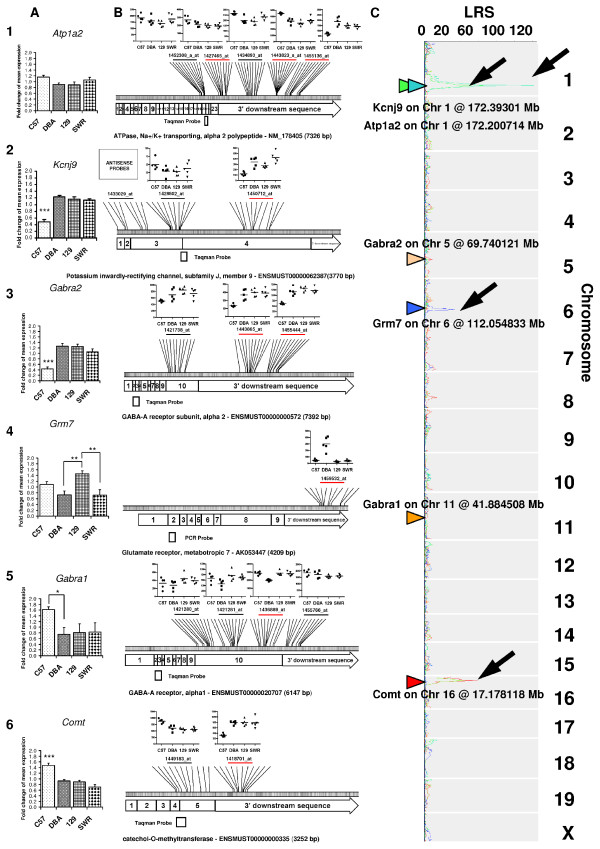
Analyses of gene expression of the six candidate genes by qPCR method (A), multiple probe-sets from the microarray (B) and genome-wide interval mapping (C). A. Results of qPCR are presented as fold change of average expression level across all the four mouse strains. Transcript region covered by Taqman probe is marked in the scheme of transcript structure. Error bars represents ± standard error of the mean from 6–9 individual animals. Statistical significance was determined by using ANOVA analysis followed by Tukey post hoc test (*p < 0.05, **p < 0.01, ***p < 0.001). B. Relative inter-strain differences in expression are presented as results from the multiple probe-sets measured by the MBEI method. Each probe was aligned with mRNA sequence and exon structure downloaded from Ensembl or GenBank databases. Image displays signal intensity from an individual array with emphasized mean value. Array probe-sets marked in red were found to be significantly different between the four strains of mice. C. Genome-wide interval multiple mapping for six probe-sets (Atp1a2 – 1455136_at, Kcnj9 – 1450712_at, Gabra2 – 1443865_at, Grm7 – 1459532_at, Gabra1 – 1436889_at, Comt – 1418701_at) in WebQTL (HBP/Rosen Striatum M430V2 (Apr05) PDNN Clean). The likelihood ratio statistics (LRS) score for association of the gene expression with genotype across genome of BXD recombinant strains for each probe-set is represented as coloured trace. Mouse chromosomes are plotted along y-axis, with the exception for chromosome Y. Coloured triangles indicate transcript locations. Cis-regulatory QTLs for Atp1a2 (1455136_at), Kcnj9 (1450712_at), Grm7 (1459532_at), Comt (1418701_at) are marked with black arrows.